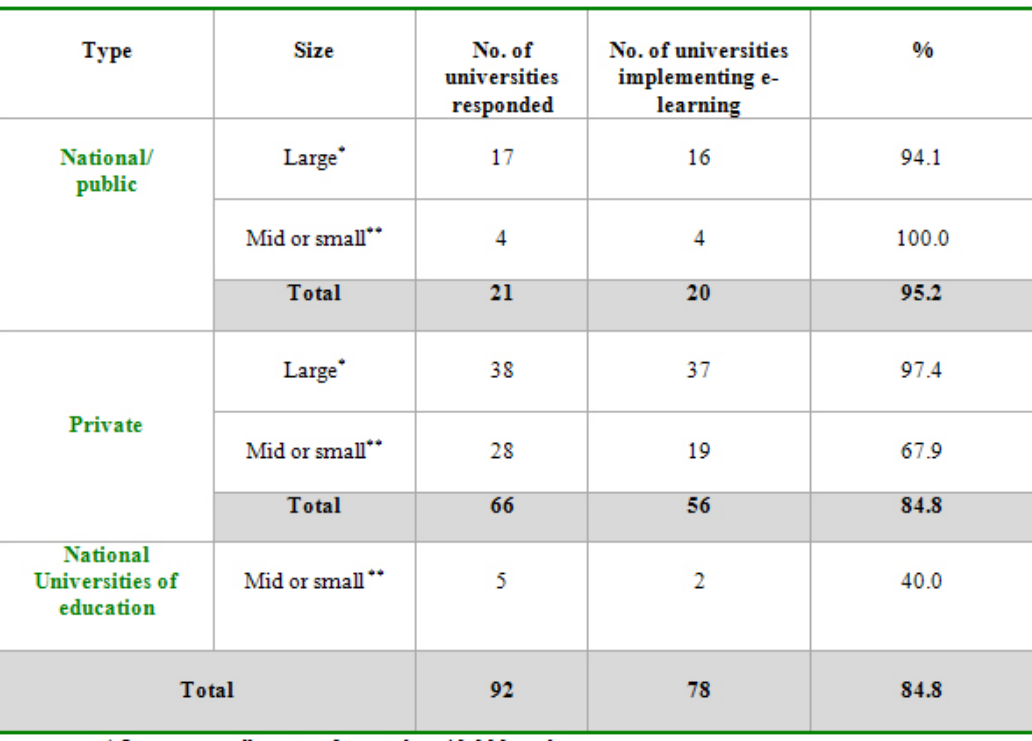
Table 2. State of implementing